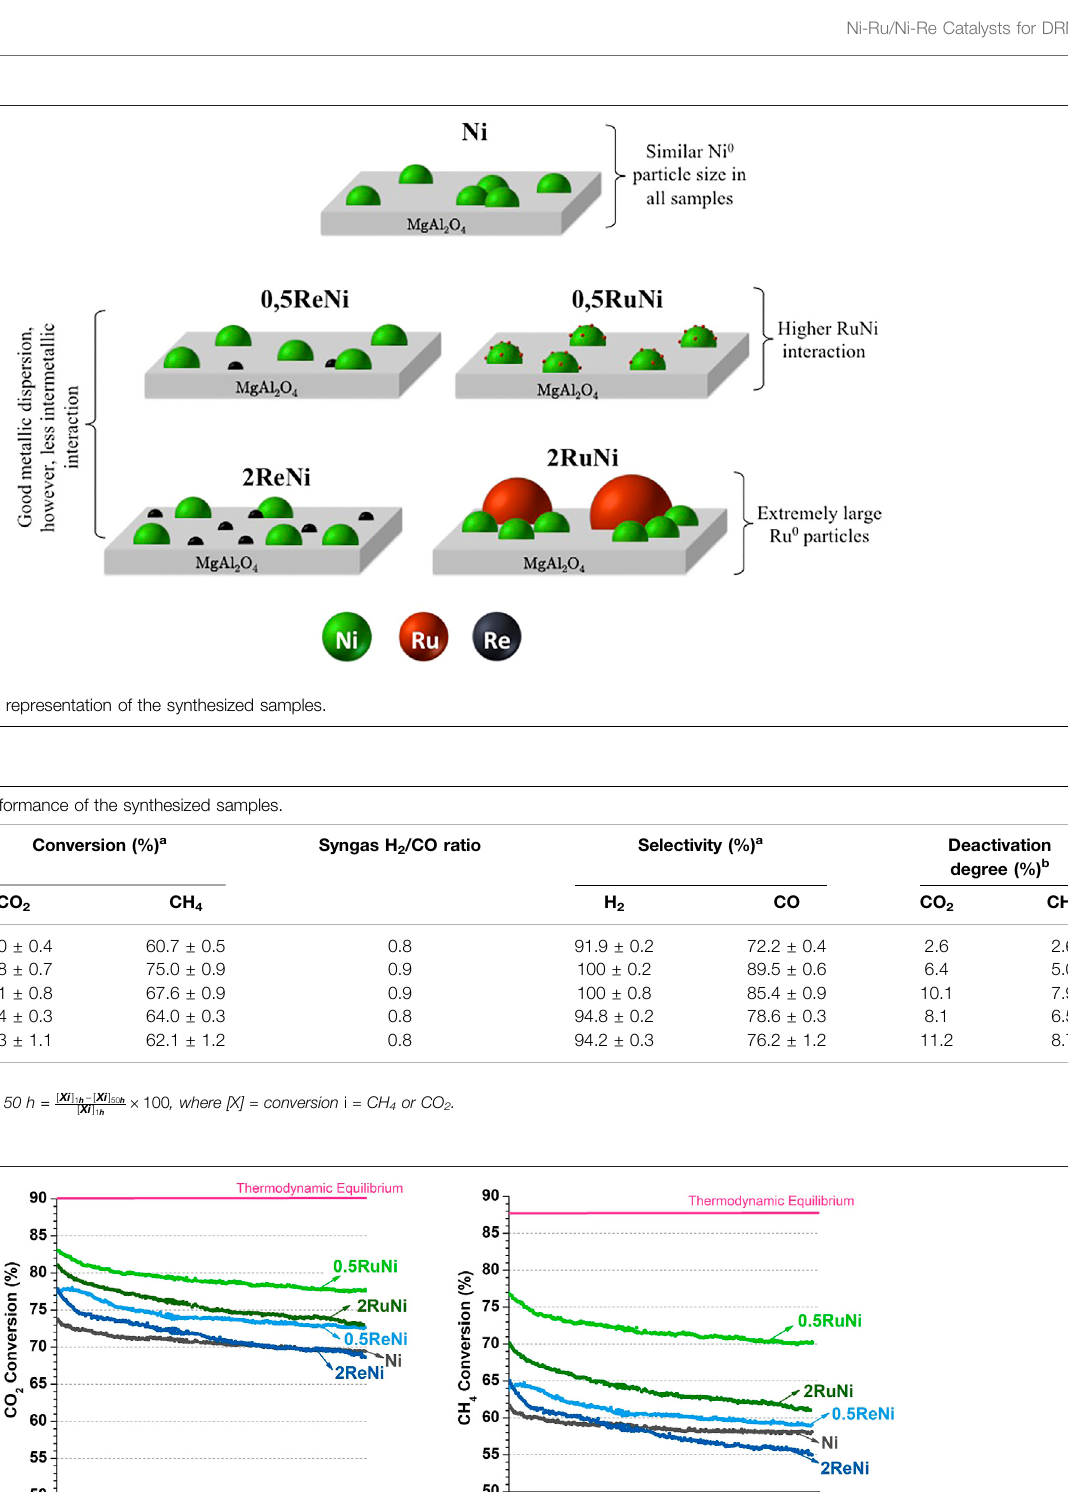
Frontiers in Chemistry |